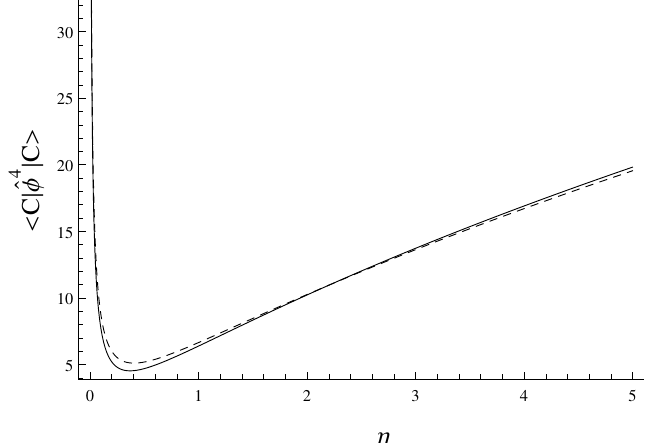
Figure 2. The mean value of ˆ φ 4 over the wave packet Equation (18) for methods. A , D : solid line and methods B , C : dashed line.